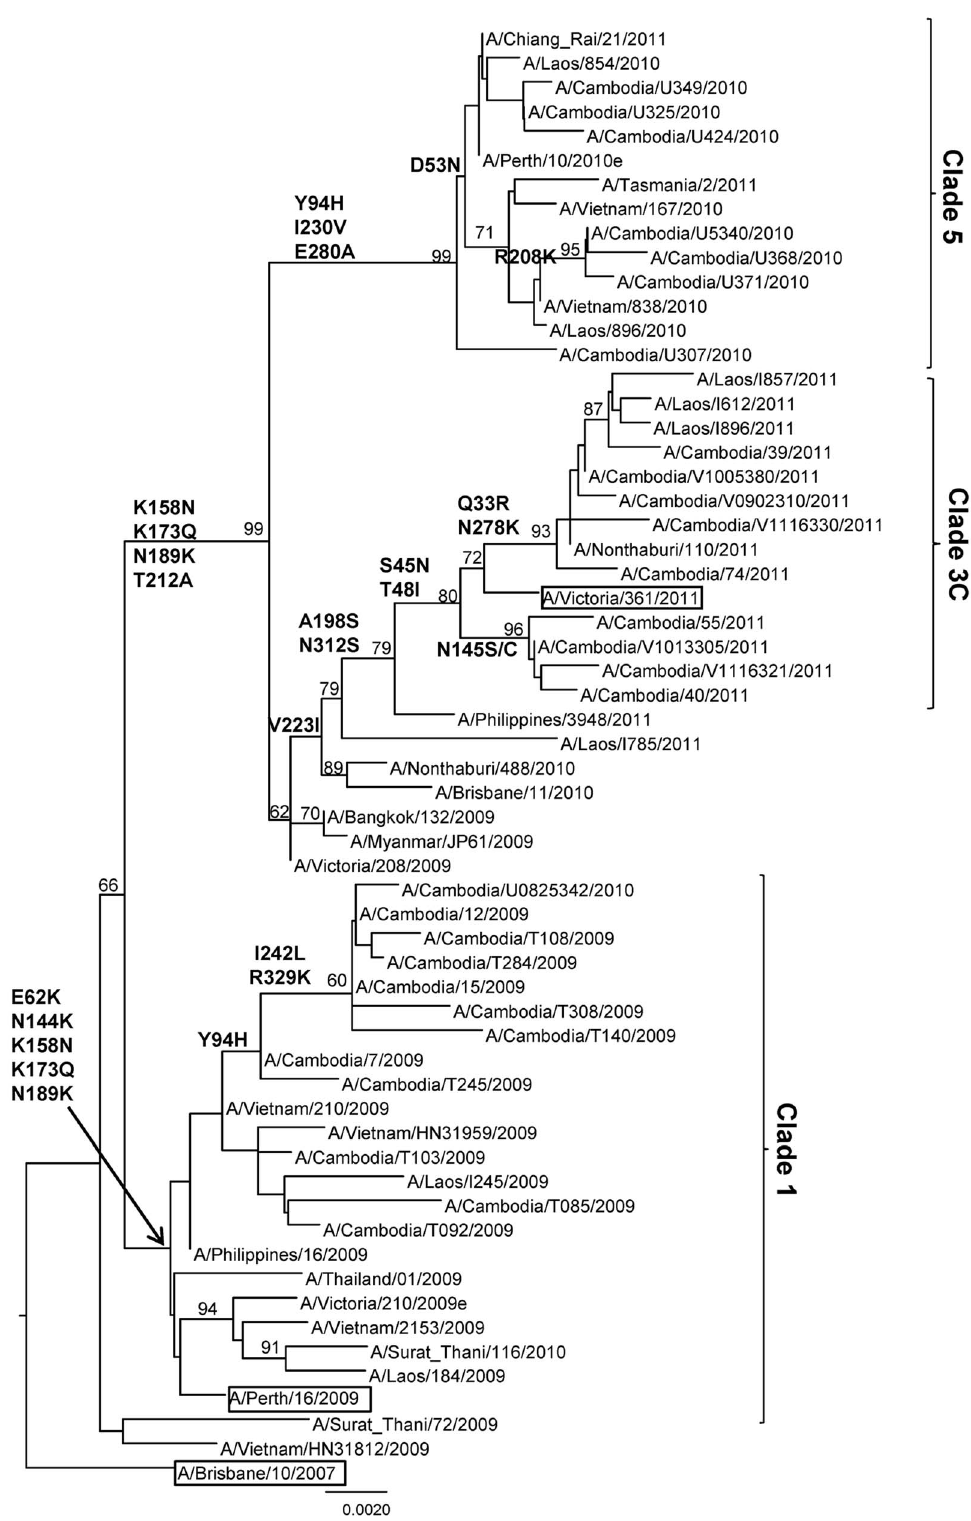
Figure 3. Phylogenetic analysis of the HA1 domains of the HA genes (sequences of 987 nucleotides (nt49–1035)) of influenza A/ H3N2 virus isolates collected in Cambodia from 2009 to 2011. The phylogenetic analysis was conducted as a distance-based neighbour- joining phylogenetic tree of influenza using the HKY model and generated using PAUP software with 1,000 bootstrap replicates (values $ 60 shown on branch) and rooted to A/Brisbane/10/2007. Major amino acid changes are shown in block letters at the appropriate nodes. The vaccine reference strains are boxed. Scale bar indicates number of nucleotide substitution per site.